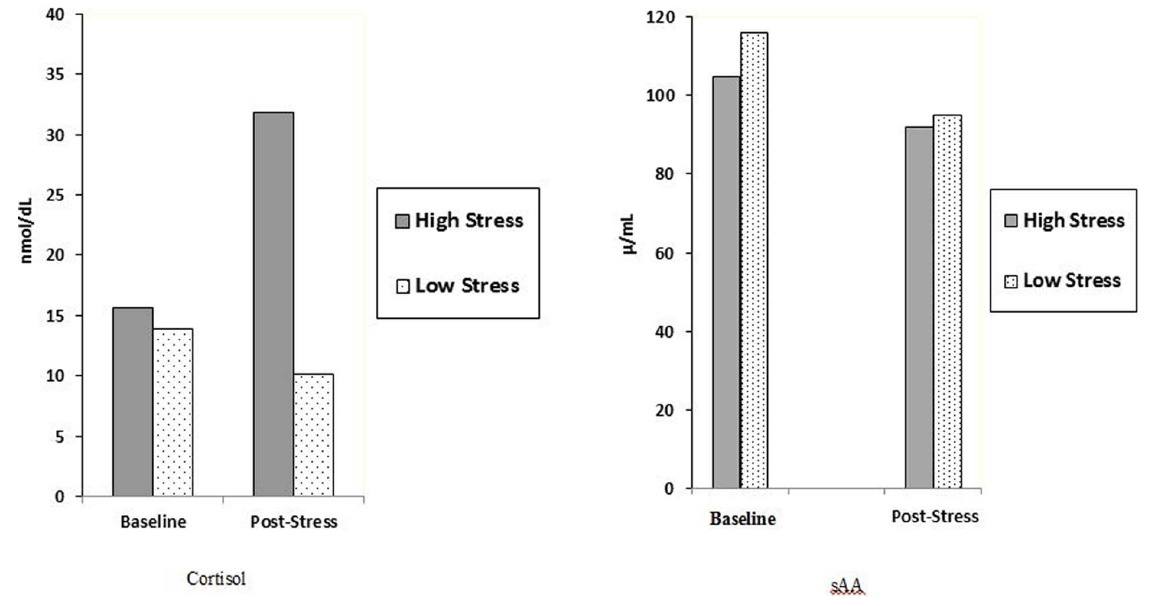
Figure 1. Average salivary alpha amylase and cortisol levels at each experimental phase. doi:10.1371/journal.pone.0062675.g001 PLOS ONE |